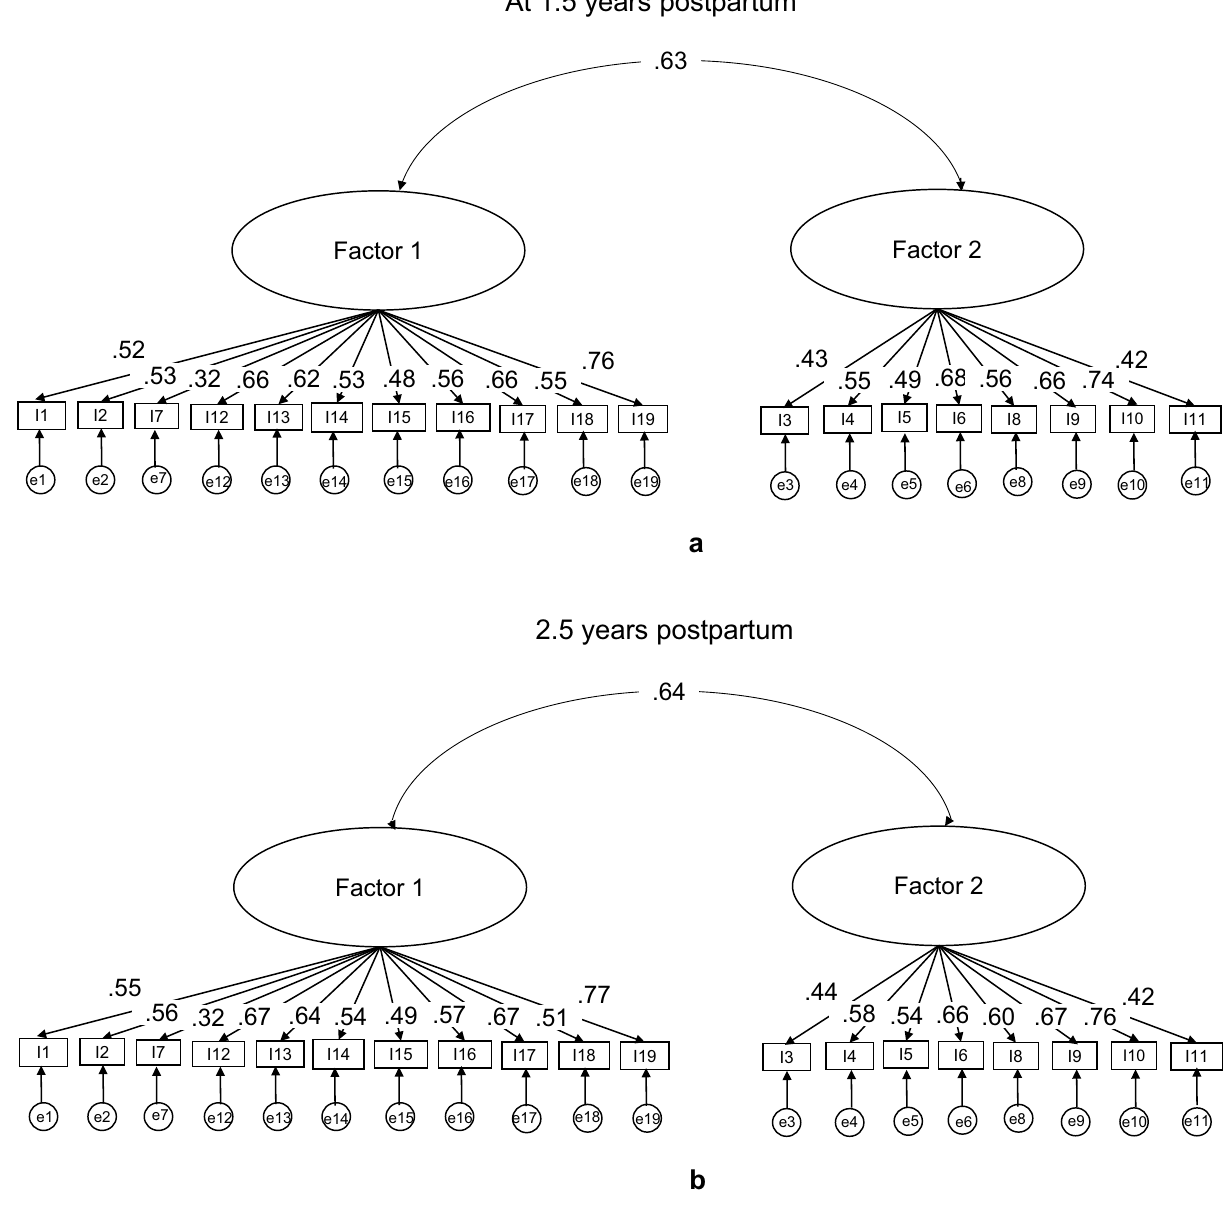
Figure 2. Path diagrams of the two-factor structure ( a , b ) and three-factor structure ( c , d ) of the 19-item PSI-SF at two parenting